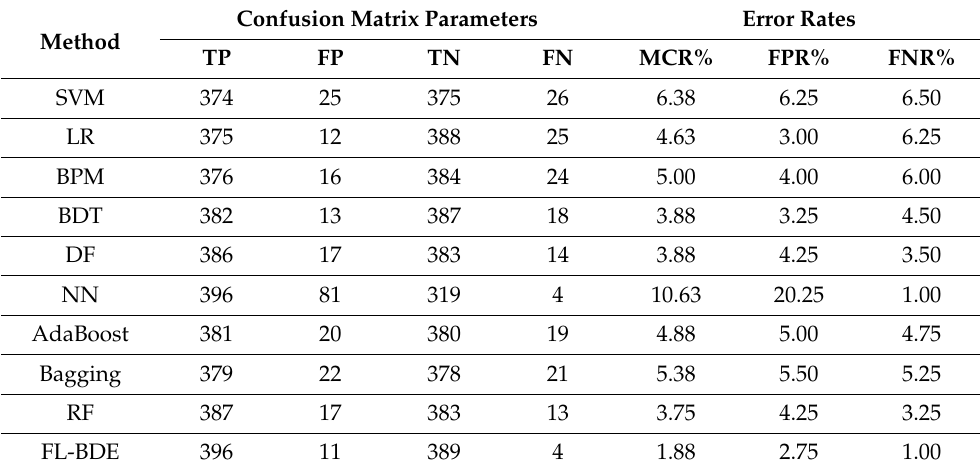
Table 3. Confusion matrix parameters and error rates of FL-BDE, ML- and EL-based models at the split ratio of